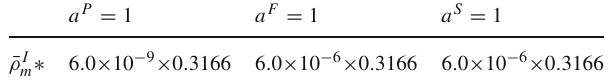
Table 3 The comoving matter density ¯ ρ I m ∗ = ¯ ρ I m ( a I ) 3 for three dif- ferent universes, where I = P , F , S for our universe, fiducial universe and simulations respectively a P = 1 a F = 1 a S =